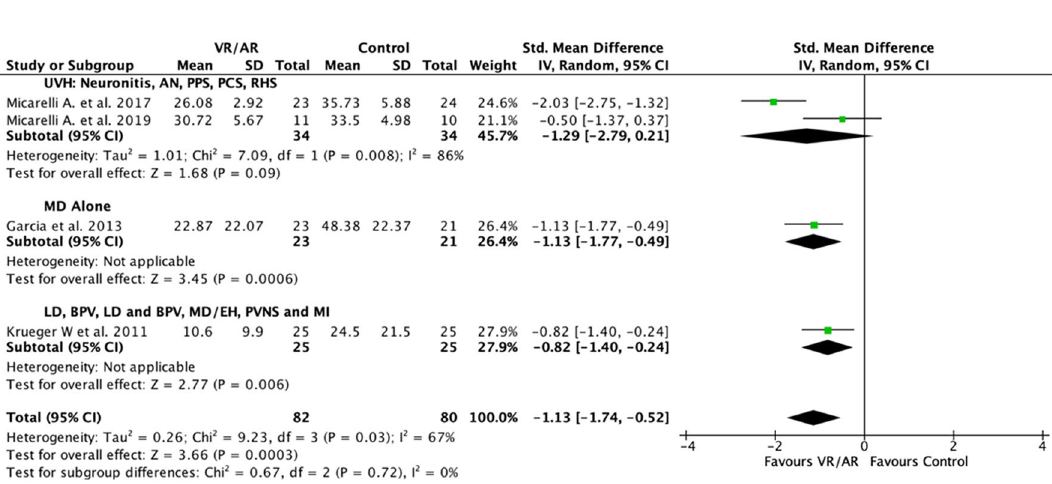
Figure 3. Post-intervention symptom index score (DHI) peripheral vestibular disorder subgroup analysis. SMDs between VR/AR and control vestibular rehabilitation for the group of UVH disorders studied by Micarelli et al. 33 and Micarelli et al. 32 , MD alone and the vestibular disorders studied by Krueger 35 are listed. AN acoustic neuroma, AR augmented reality, BPV benign positional vertigo, DHI dizziness handicap index, EH endolymphatic hydrops, LD labyrinth dysfunction, MD Meniere’s disease, MI motion intolerance, PCS previous cochlear surgery, PPS previous periosteal surgery, PVD peripheral vestibular disorder, PVNS previous vestibular nerve section, RHS Ramsay Hunt syndrome, SMD standardized mean differences, UVH unilateral vestibular hypofunction, VR virtual